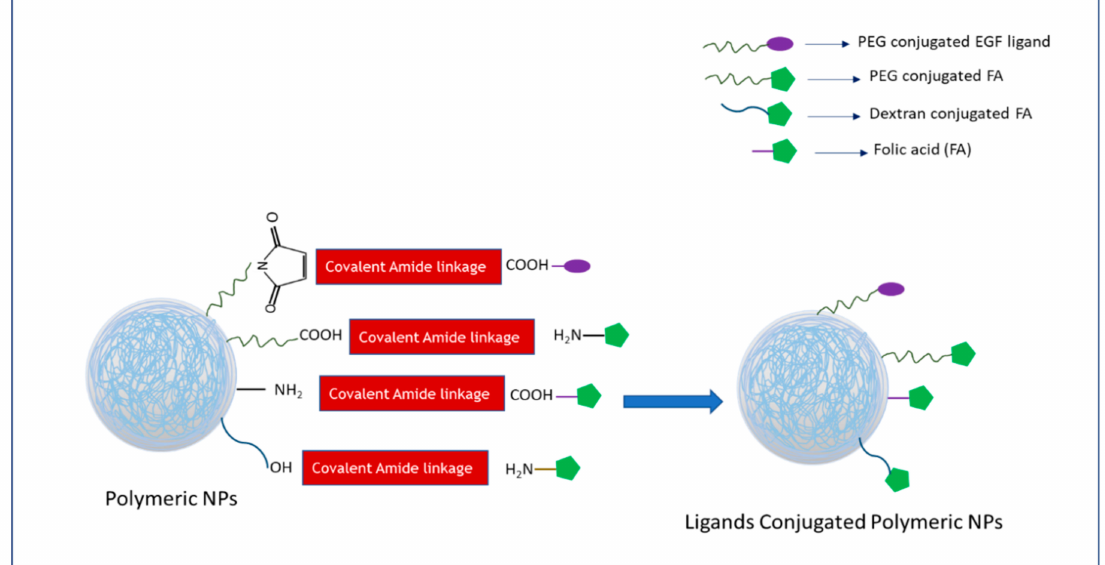
Figure 5. Strategies in conjugation ligands with polymeric nanoparticles: schematic representation of the reactions between the functional groups of polymeric nanoparticles and multiple ligands via covalent amide